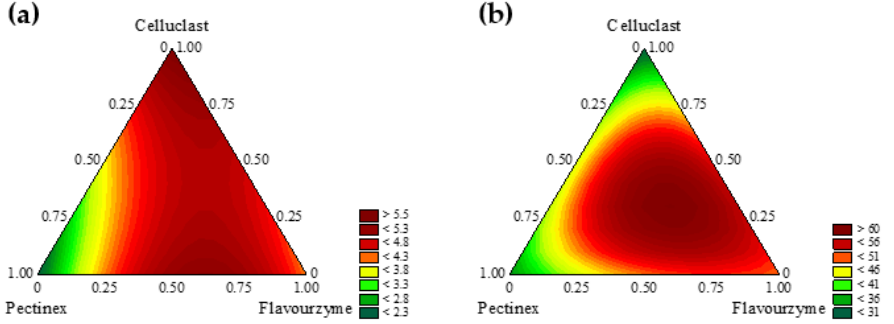
Figure 1. Contour plots for total phenolic compound (TPC) ( a ) and antioxidant activity evaluated by ABTS ( b ) method for banana bract extracts (Nanica variety).